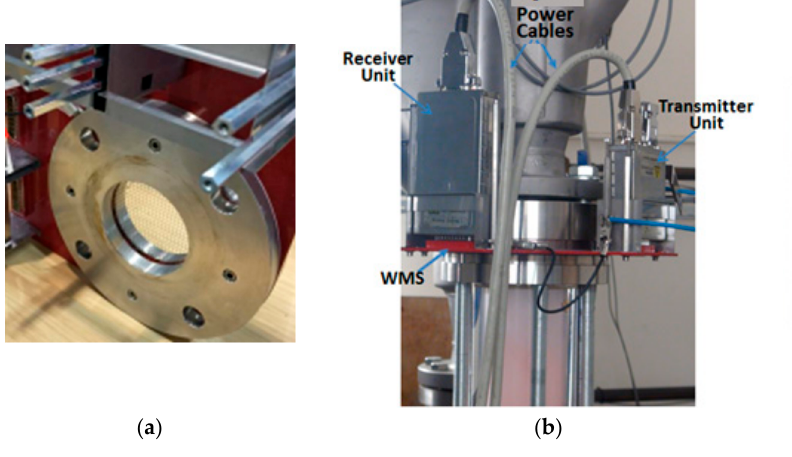
Figure 2. ( a ) Image showing 16 × 16 WMS, ( b ) the WMS installed on the riser showing the transmitter and receiver units ( c ) The capacitance WMS electronic box (model used is CAP